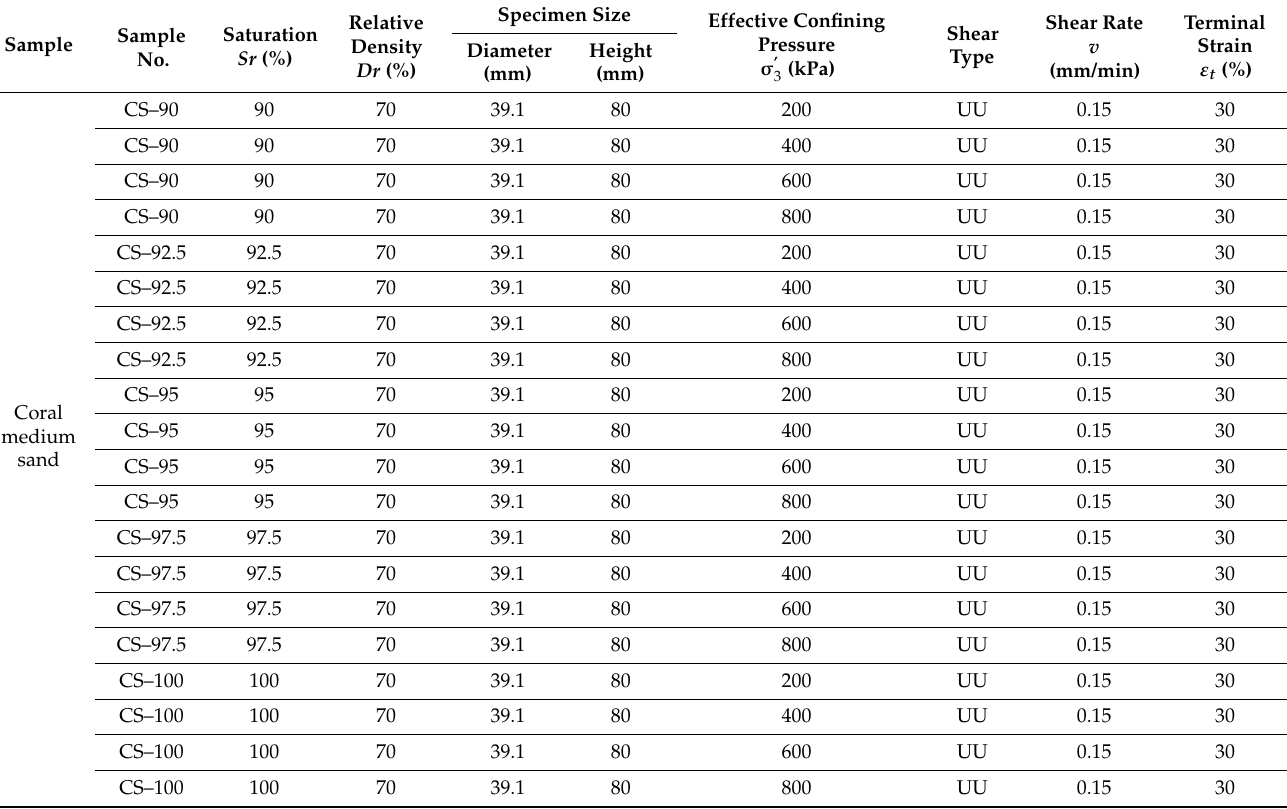
Table 4. Triaxial shear test